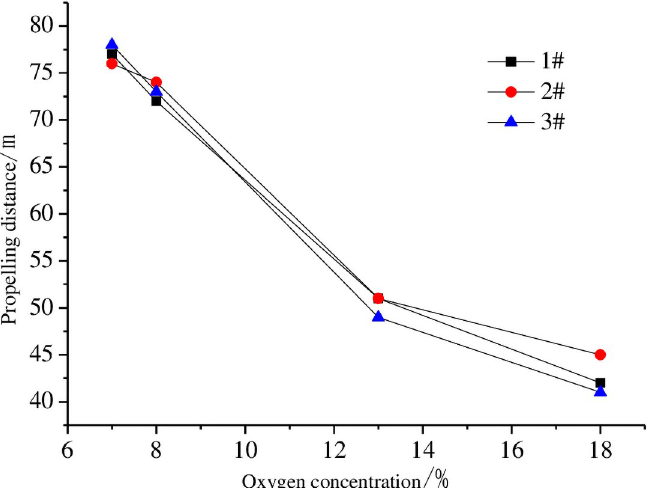
Fig 7. Change of oxygen concentration at each measuring